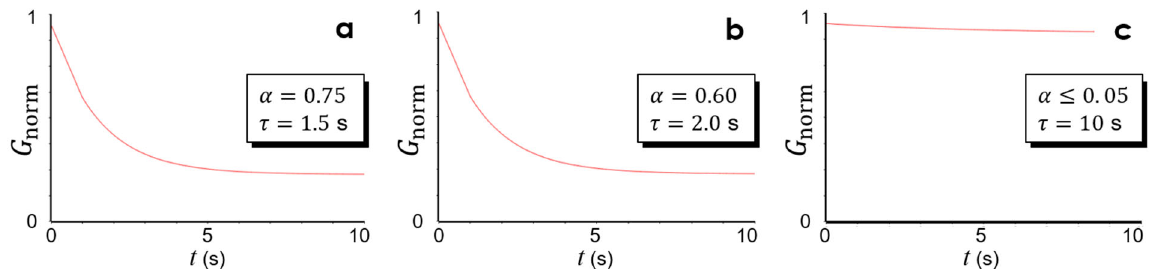
Figure 6. ( a – c ) Prony series models for the three UV doses in Table 1 (1.9 J/cm 2 , 2.4 J/cm 2 , and 2.8 J/cm 2 ), respectively.